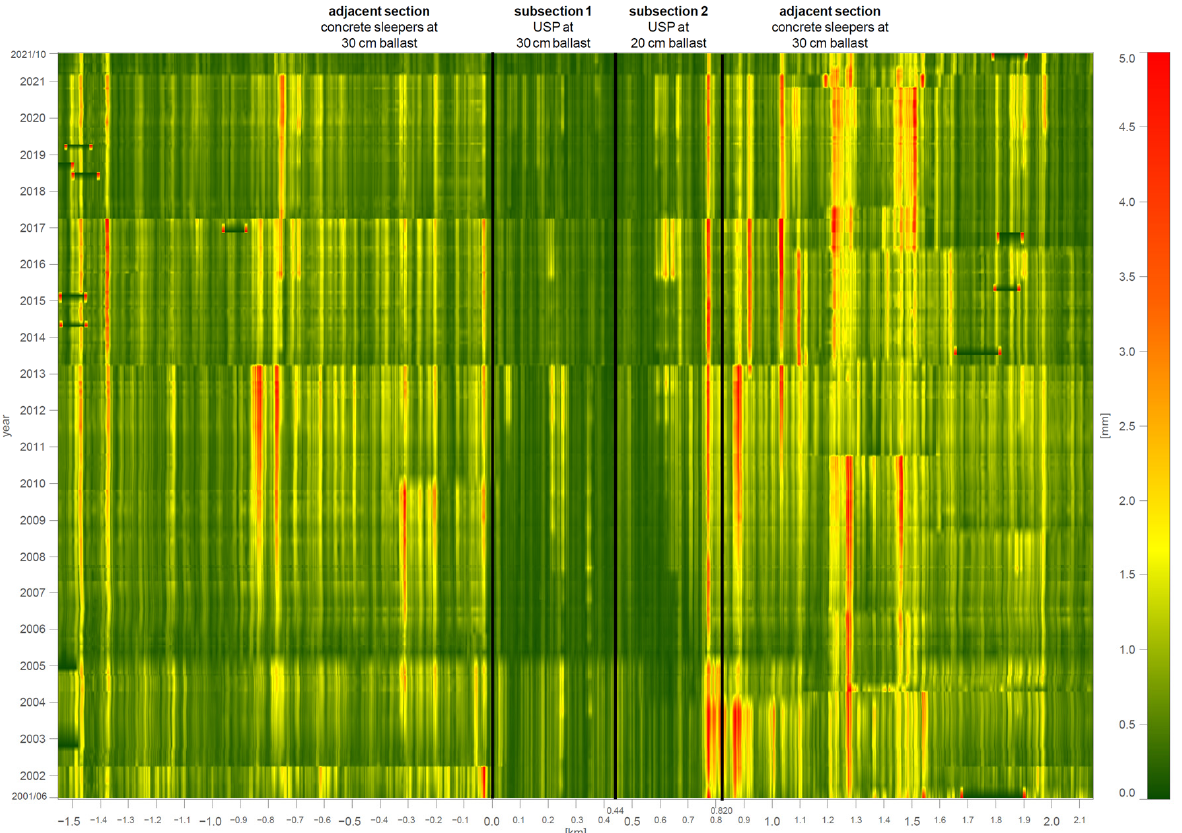
Figure 3. Waterfall diagram of SD i (100 m): arithmetic mean of the left and right rail’s standard de- viation with an influence length of 100 m.